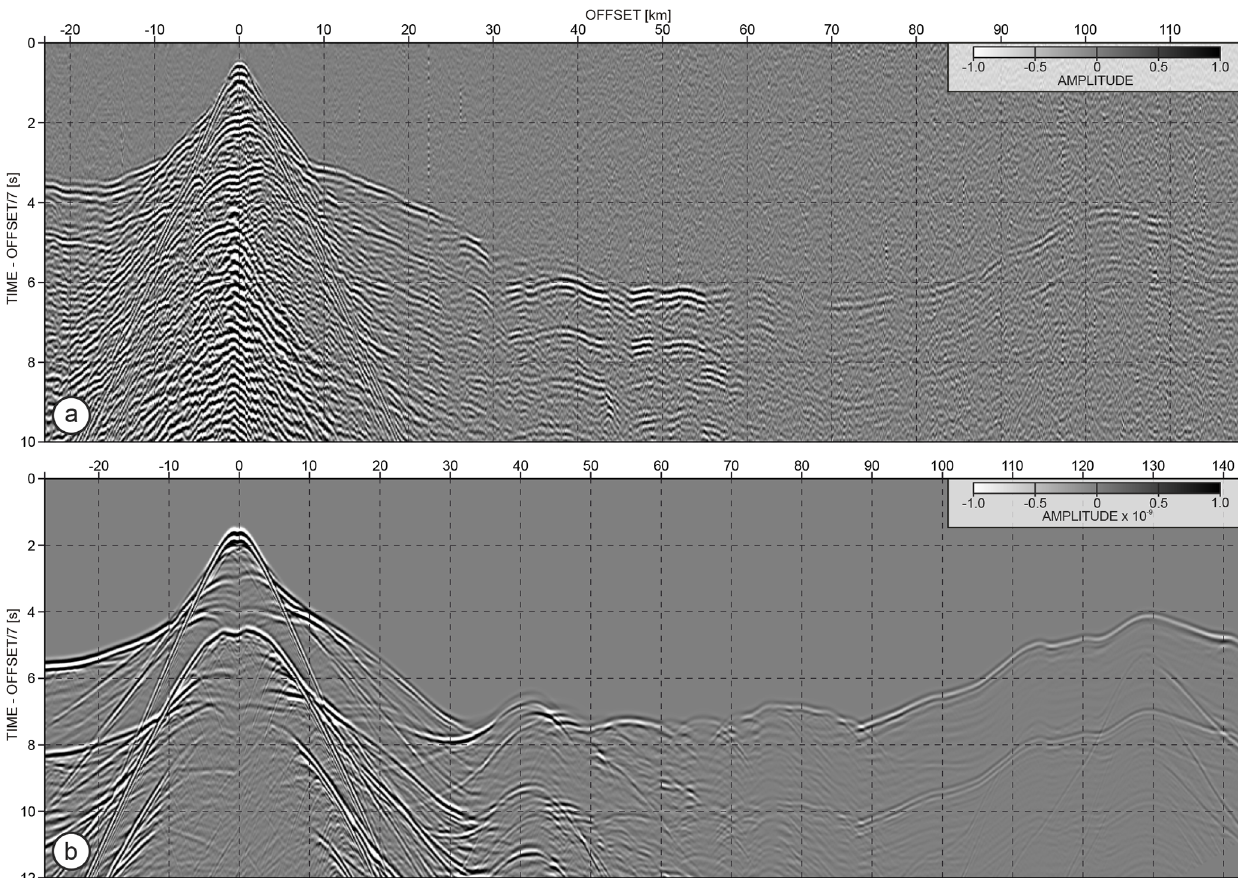
Figure 5. Comparison of the (a) field and (b) synthetic OBS gathers. The gather in (a) comes from the OBS 21 of the SFJ OBS 2001 experiment, while the gather in (b) comes from the waveform modelling for the OBS located at 30km model distance of the 2D inline model presented in Fig.